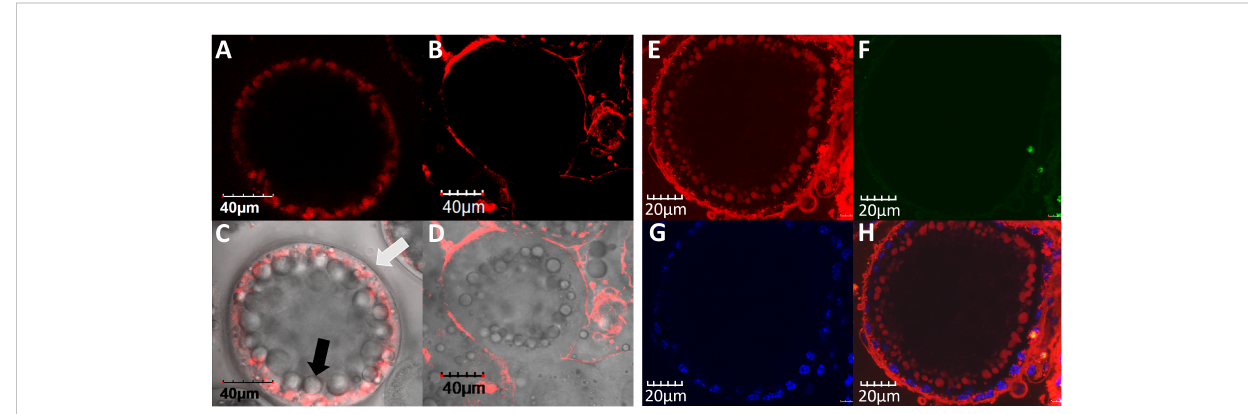
FIGURE 2 VgP endocytoses into M. rosenbergii early vitellogenic oocytes. In-vitro incubation of ovary pieces in the presence of VgP-TAMRA (A, C) , ScVgP- TAMRA (B, D) , or VgP-TAMRA + ScVgP-FITC (E – H) . A and B are TAMRA fl uorescence emission images. (C , D) show the overlay images of (A , B) , respectively, with the bright fi eld image of the same oocyte. The white arrow in (C) points to the oocyte membrane, and the black arrow points to Vg accumulation inside the oocyte. (E, F) are confocal images of the VgP-TAMRA (red) and scVgP-FITC (green) emissions, respectively. (G) shows the nuclear DNA of follicular cells with Hoechst staining (blue). (H) shows the overlay image of (E , G)